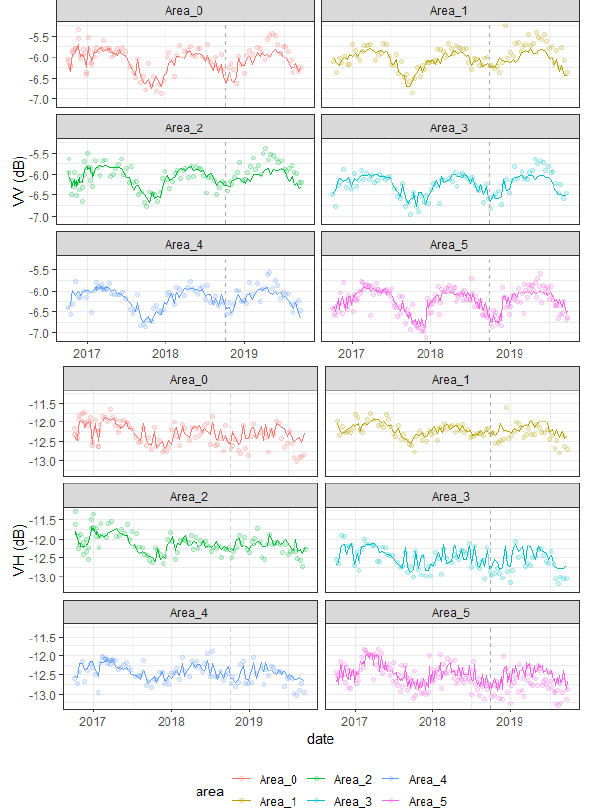
Figure 7. Predicted backscattering time-series on each studied forest tract for VV (top) and VH (bottom) backscattering. The dashed vertical line specifies the start of the validation period.